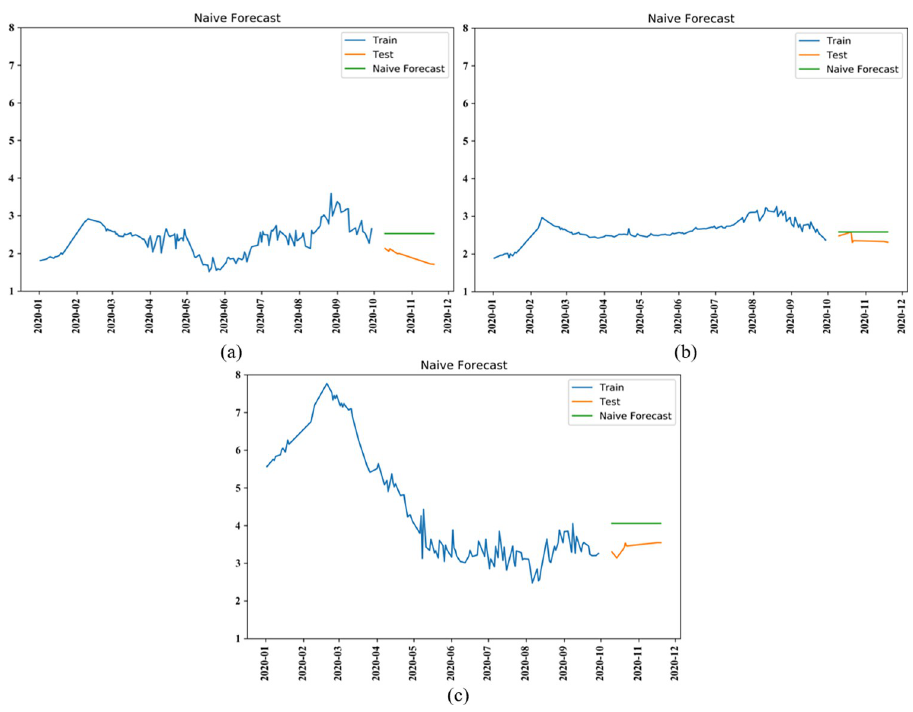
Fig 19. Naive forecast for price of cabbage (a), carrot (b), and eggplant (c).